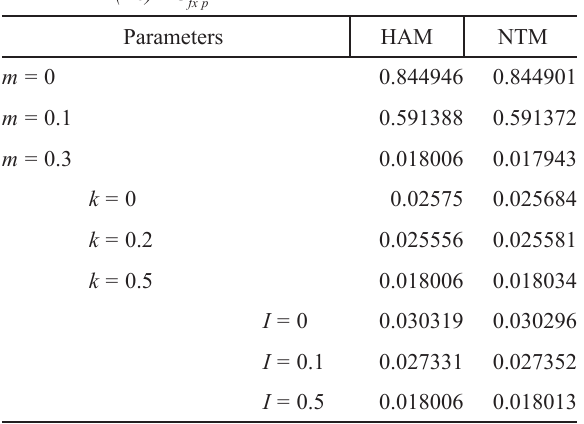
Table 2 – Effect of parameters on primary skin friction, (Re) 1/2 C fx p Parameters HAM